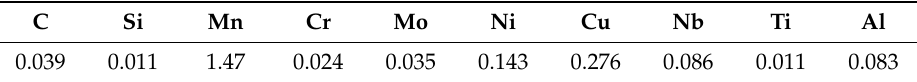
Table 2. Chemical composition of X-70 steel.